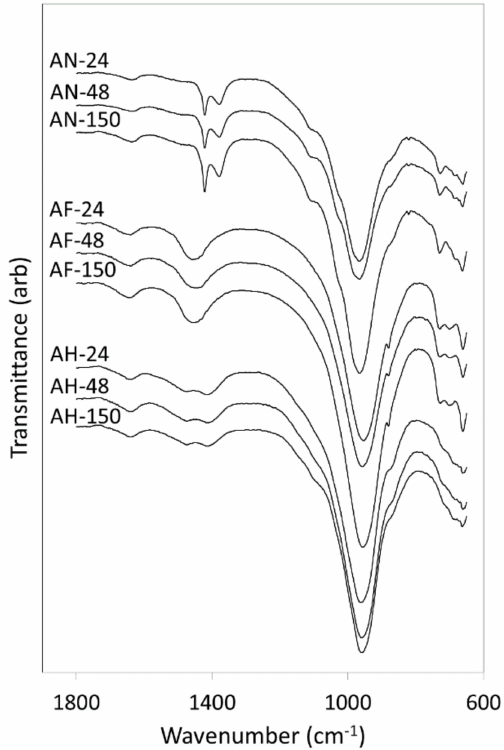
Figure 2. FTIR spectra of hydrothermal products of amber container glass and aluminium nitrate (AN), aluminium foil (AF) and amorphous aluminium hydroxide waste (AH) synthesised for 24, 48 and 150 h in 4.5 M NaOH (aq) at 100 ◦